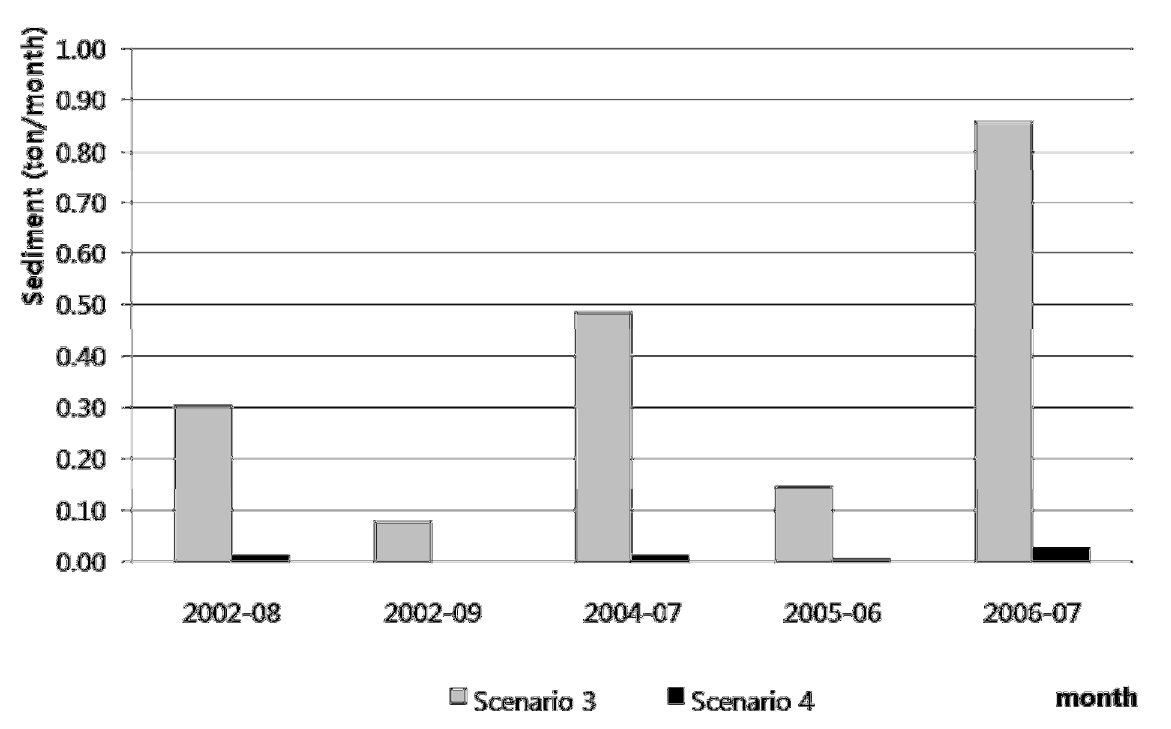
Figure 20. Simulated Monthly Sediment at Subwatershed 4–receiving subwatershed in SG 4